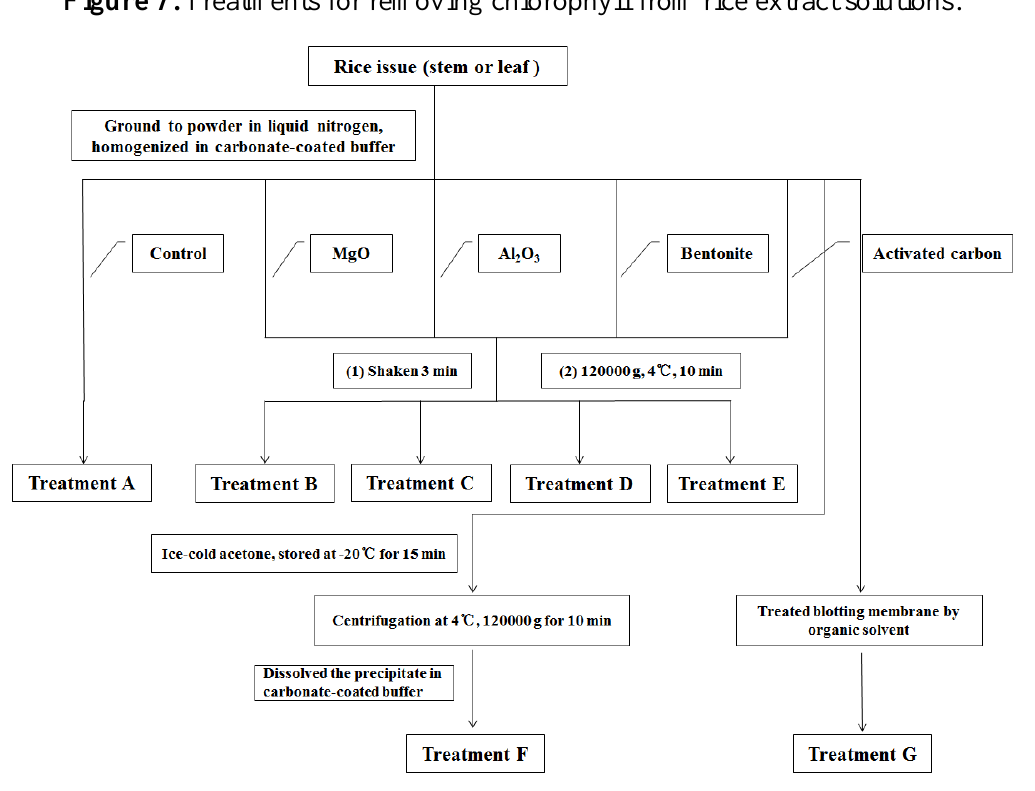
Figure 7. Treatments for removing chlorophyll from rice extract